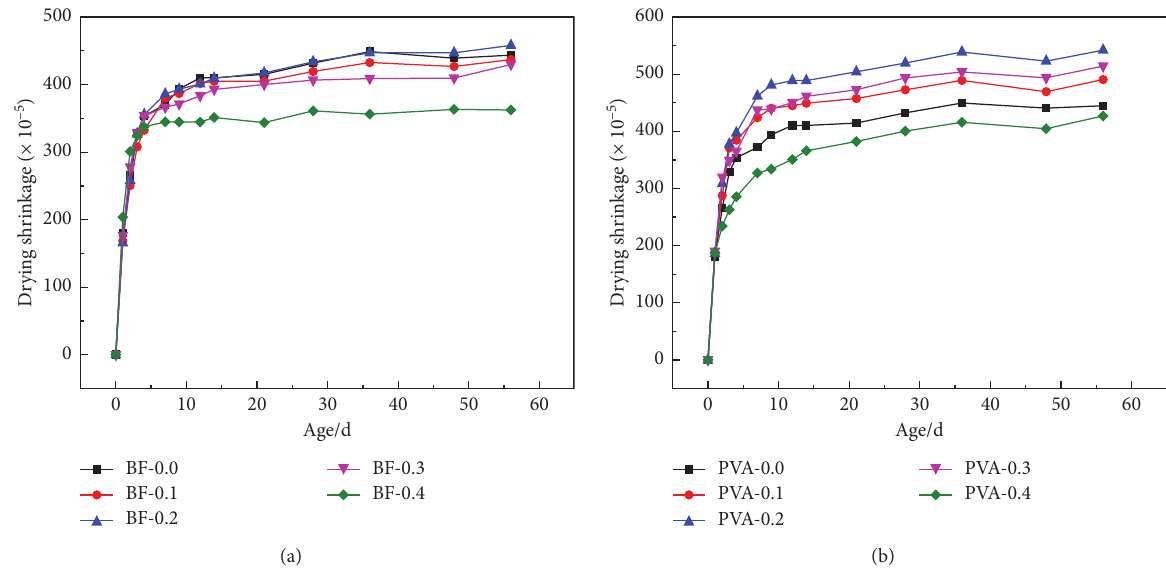
Figure 4: Effect of the content of (a) basalt fibre and (b) PVA fibre on drying shrinkage of geopolymer